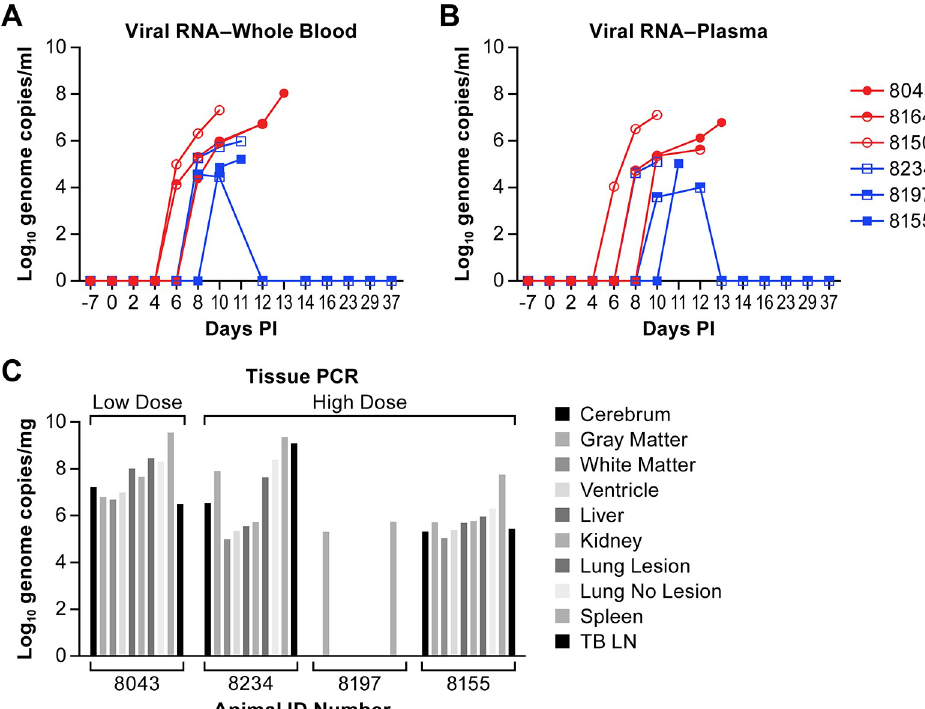
Fig 5. Determination of viremia and viral RNA distribution. Whole blood (A) and plasma (B) were collected and viral RNA levels quantified using a viral genome specific RT-PCR assay that targets a genome intergenic region [26]. Genomic titers for individual animals in the low dose (red circles) and high dose (blue squares). (C) The level of virus RNA was determined in multiple tissues from four of the six animals included in the study. The limit of detection for this PCR assay is approximately 6x10 3 genomes per